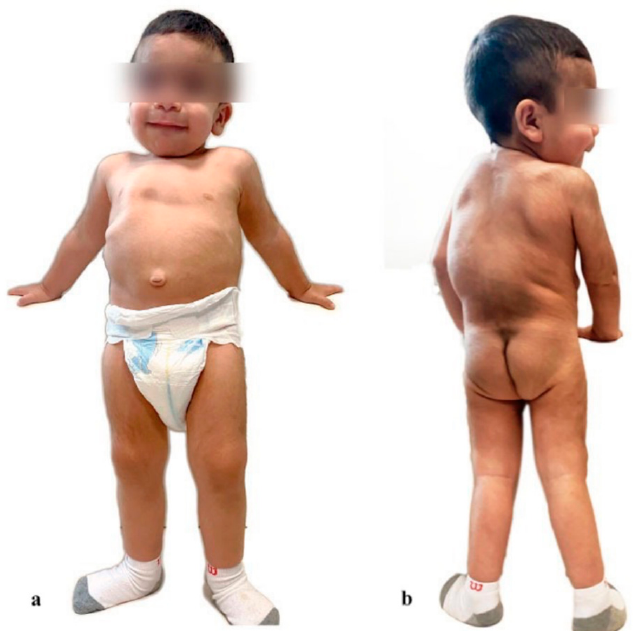
Figure 3. Index patient’s full body anterior and posterior view. ( a ) Anterior view: macrocephaly, pectum excavatum, and umbilical hernia. ( b ) Posterior view: short neck, dorsal kyphosis, and a lumbosacral Mongolian spot.